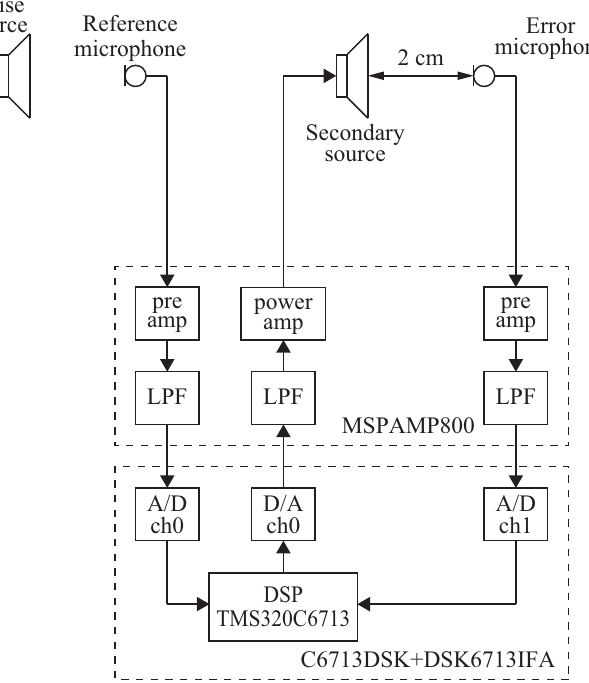
Figure 6. Implementation of the